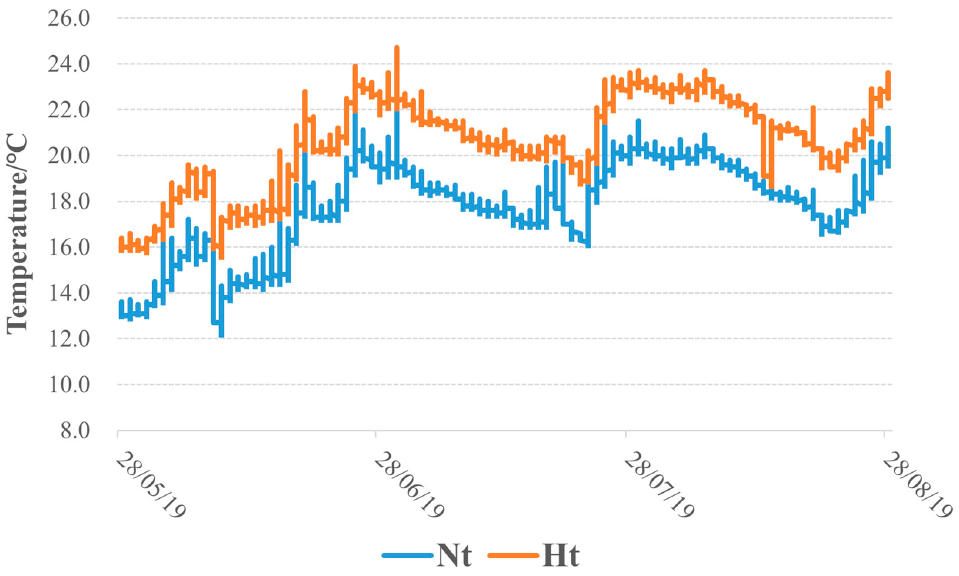
Figure 1. Temperature variation during the period from 28 May to 27 August 2019. Nt: normal sea- water temperature. Ht: 3 °C higher temperature. The times on the X-axis represent the sampling dates.